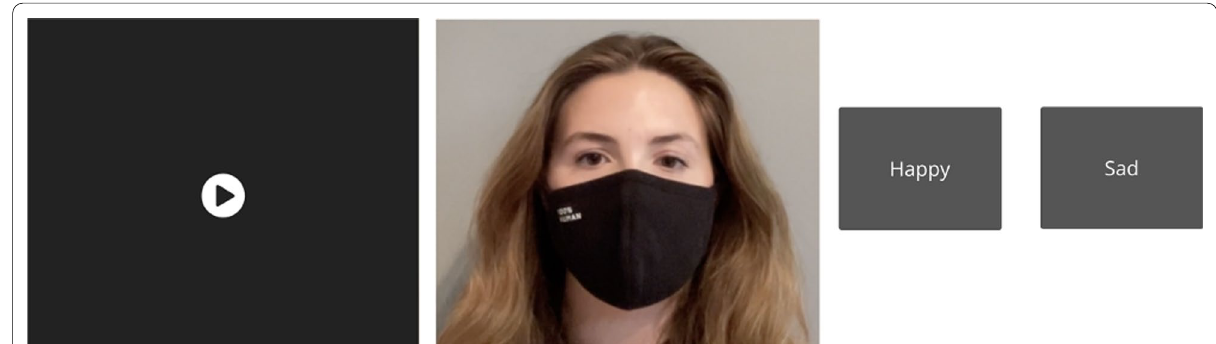
Fig. 2 Prosody task sequence from left to right: mouse-click play button, video played only once, prosody